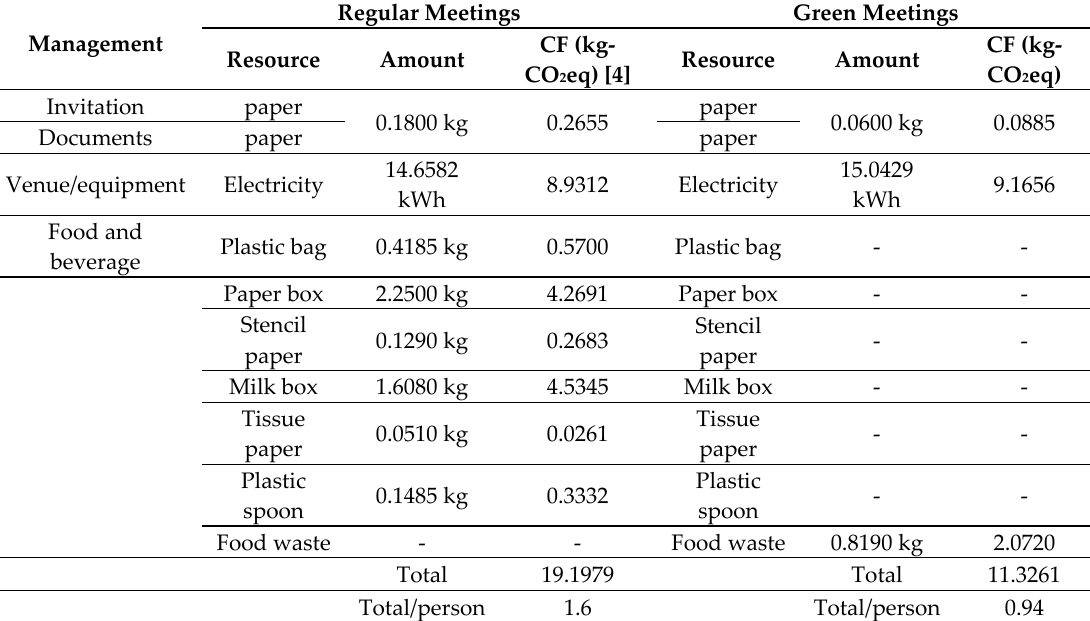
Table 1. Comparison of regular and green meeting’s carbon footprint of room